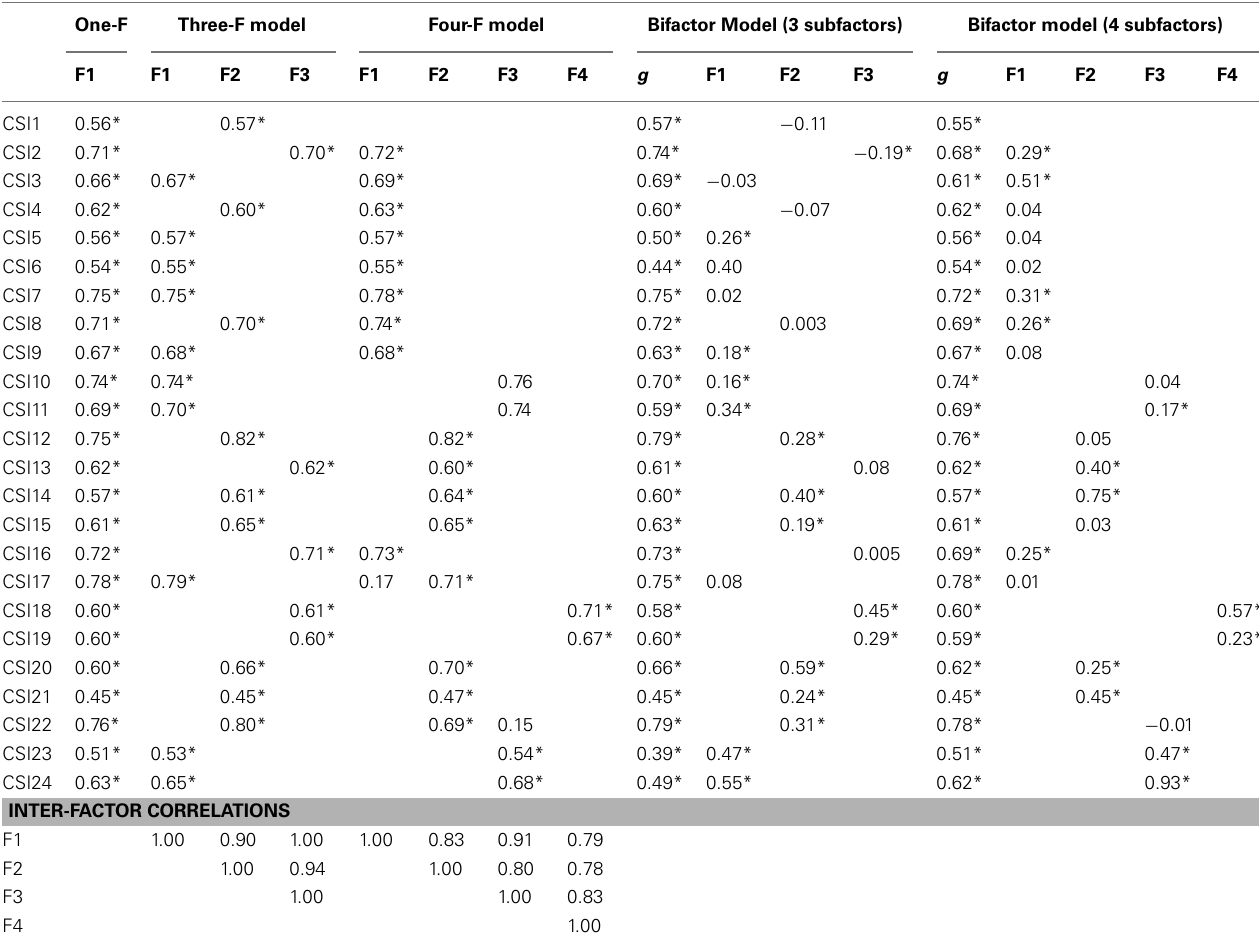
Table 3 | Factor-loadings and inter-factor correlations for the CSI-24.